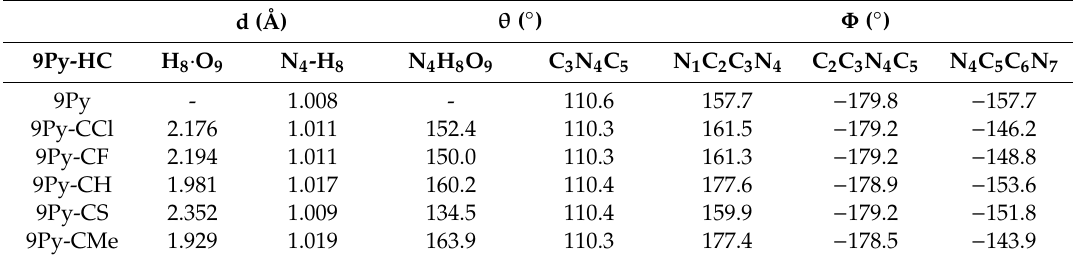
Table 3. Structuralparametersfortheoptimized9Py-HCcomplexesattheB3LYP-D3(BJ) / 6-31 +